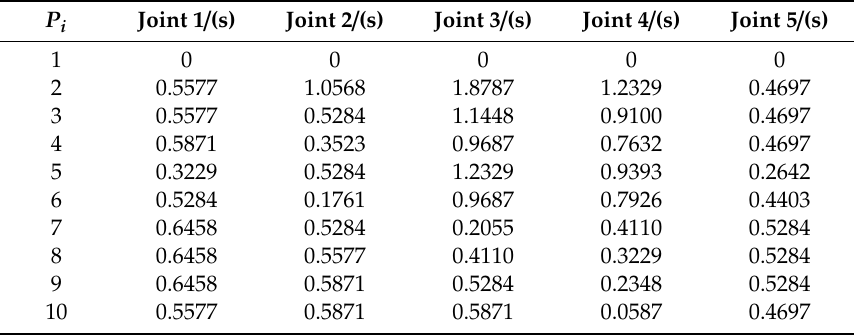
Table 6. Time optimization results of the pickup manipulator at each path